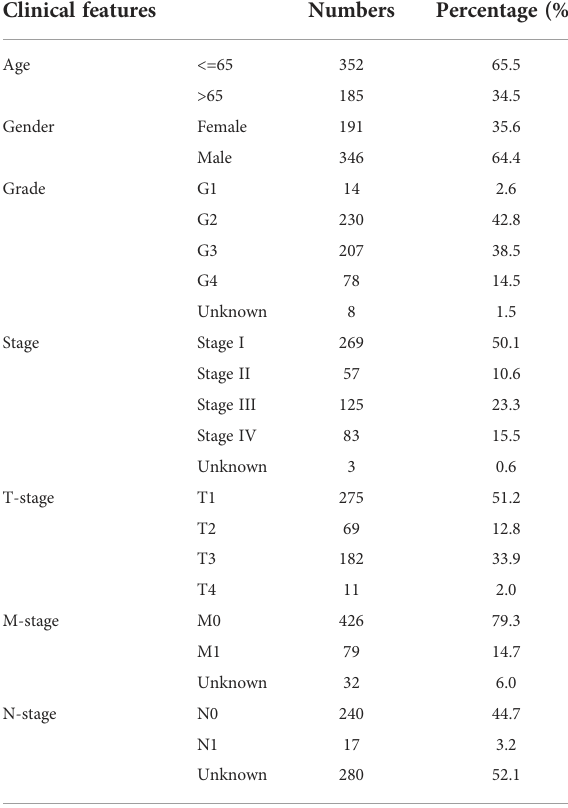
TABLE 1 Baseline information of patients in